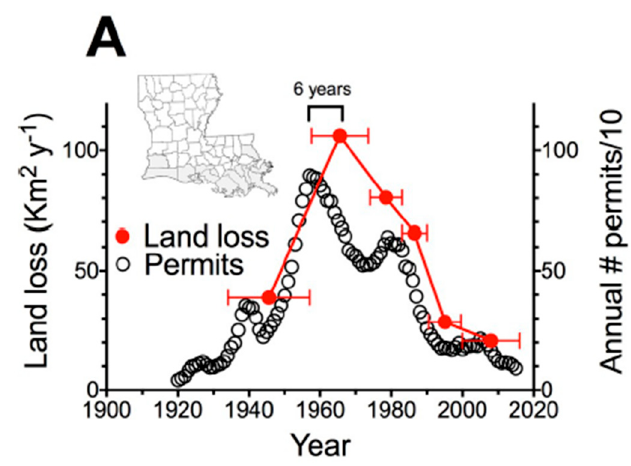
Figure 4. The number of oil and gas permits issued annually and land loss rates [18].